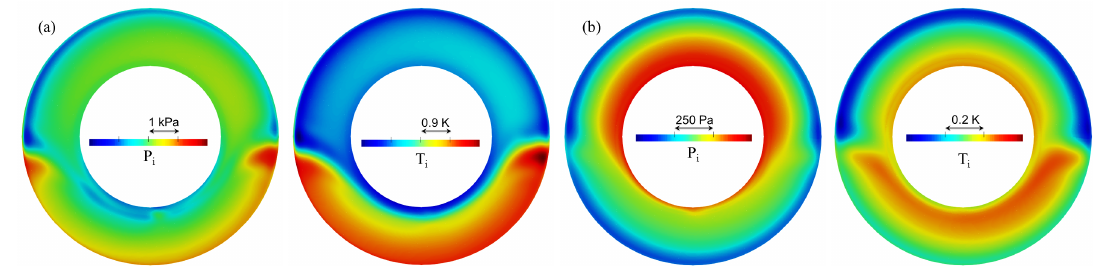
Figure 16. Total pressure and total temperature downstream of the rotor, assuming the same V z , P i , T i conditions from URANS and uniform zero swirl angle: compressor ( a ) and free windmill ( b